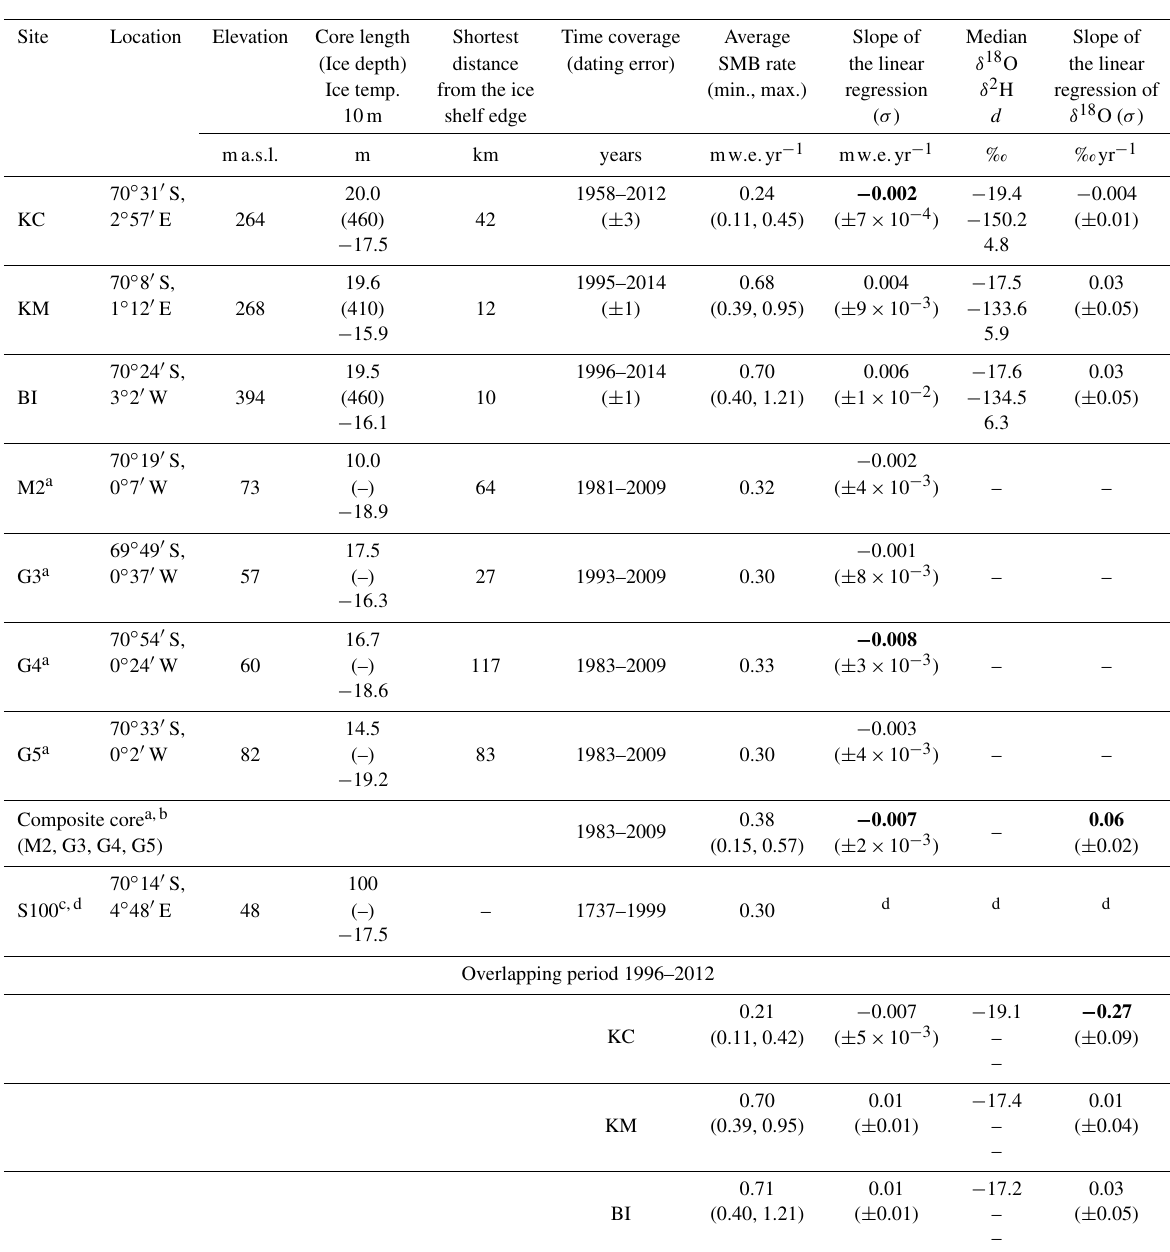
Table 1. Core locations, sampling details, SMB rates derived from the KC, KM, and BI δ 18 O records as annual average values between summer maxima. Median water stable isotope deltas (in ‰) quantified in each core are also shown. Distances from the core locations to the ice shelf edge were obtained using the GIS package Quantarctica (www.quantarctica.org). Both annual layer counting and volcanic horizons identified in the non-sea-sulphate (nssSO 2 − ) were used to obtain timescales for the cores. Significant values (at 95% confidence level) are 4 shown in bold. ( a , b ) refers to Schlosser et al. (2012, 2014), ( c ) to Kaczmarska et al. (2004), and ( d ) to Divine et al.